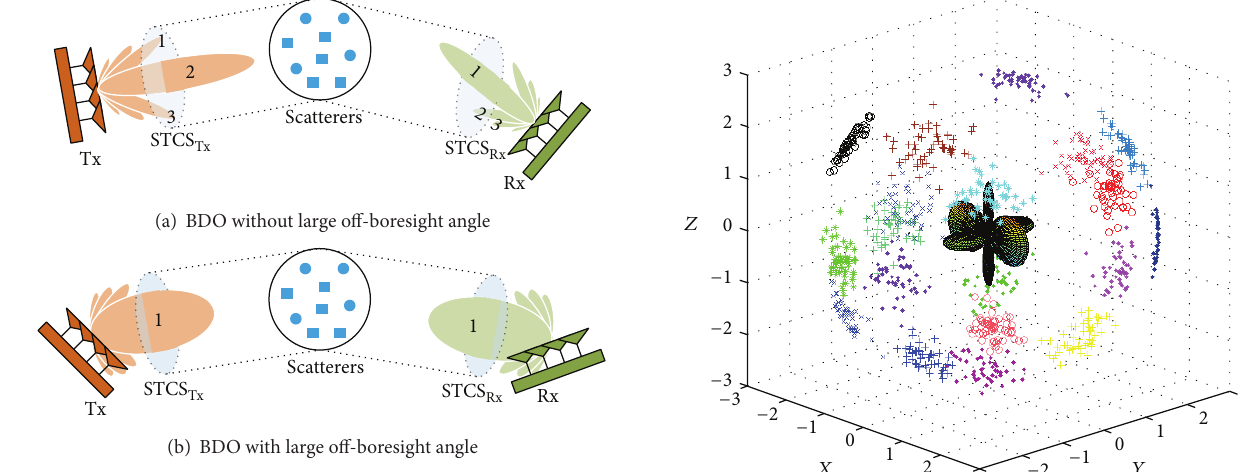
Figure 10: Transmission scenario with beamforming technology.